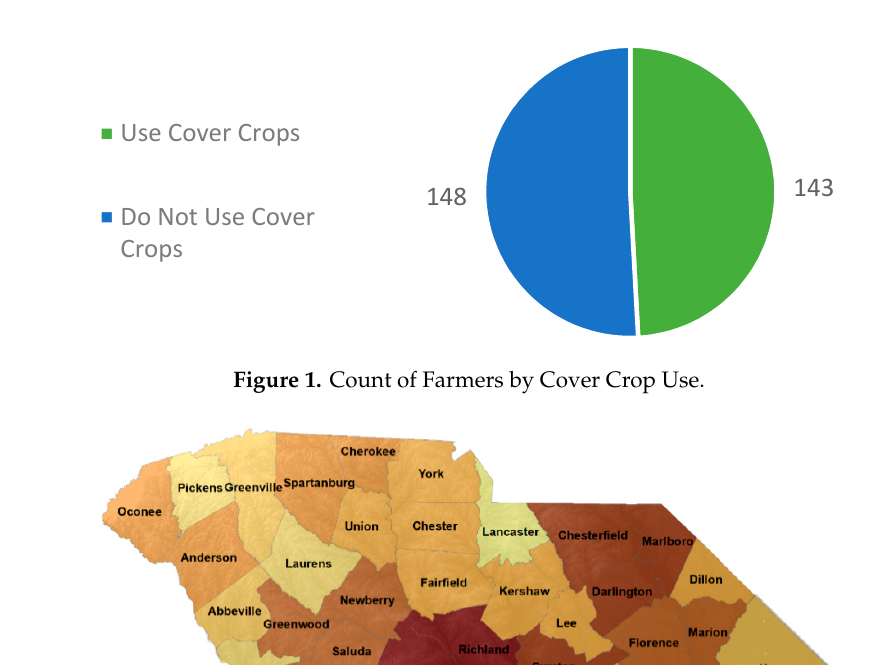
Figure 2. Distribution of respondents from each county in SC, count indicated by color.